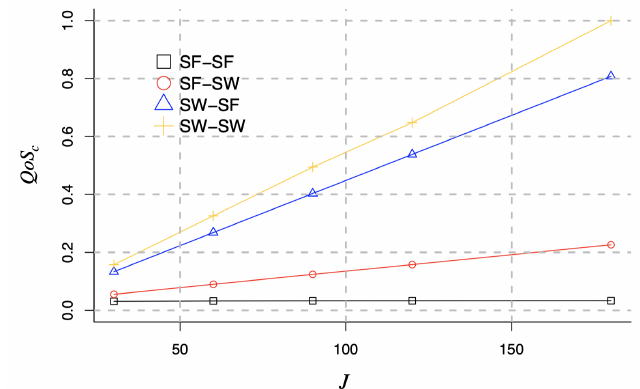
Figure 4. Complex QoS in function of population size and network-topology hypothesis of the temporal multilayer quality network. We shed light on the complex QoS in function of the J numbers of parameters, and population of M (cid:48) . We took into consideration different network topology hypotheses for the co-adoption in M (cid:48) . We explore four cases, choosing scale-free (SF) or small-world networks (SW). In each case, the first topology indicates the intra-layer scheme, while the second one indicates the inter-layer scheme.